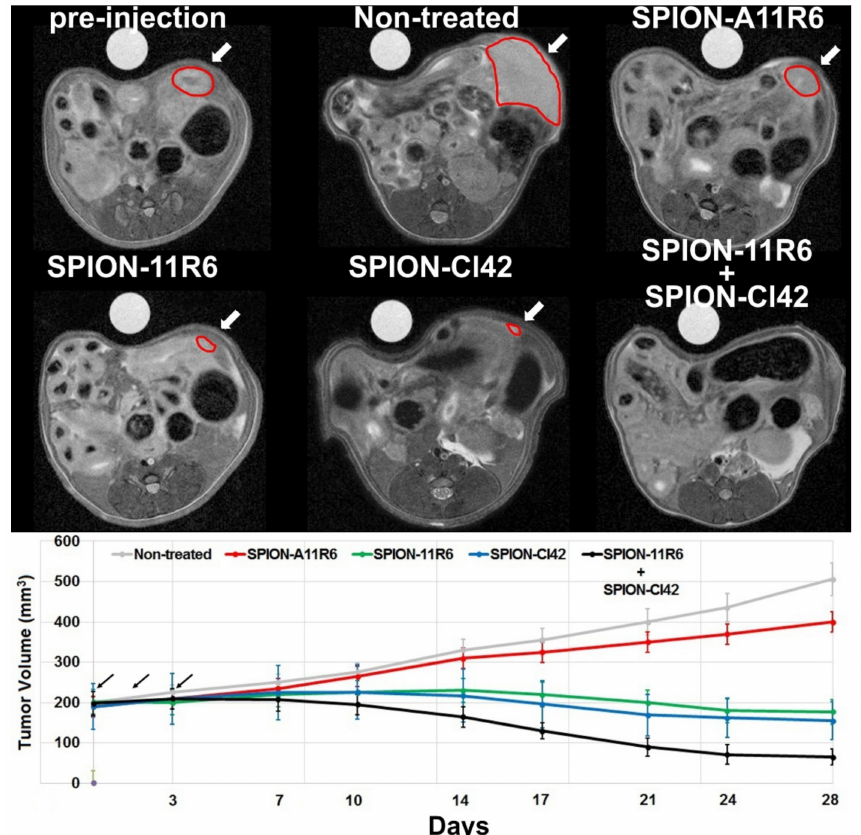
Figure5. In vivoaptamer-conjugatedSPIOnanoparticletherapeutice ffi cacyassessedusingnoninvasive MRI. Representative axial MR images (upper row) and corresponding quantitative measurements of tumor volume (lower row) in 4T1 tumor-bearing mice. Noninvasive imaging protocols were performed pre- ( t = 0; corresponding to three-weeks post-tumor cell inoculation in the mammary fat pad) and up to 28 days post-injection of three consecutive doses (24 h interval time) of di ff erent aptamer therapeutic formulations. Black arrows highlight the injection time points. Pre-injection, non-treated mice, SPION-A11R6, SPION-11R6, SPION-Cl42RNA, and combined SPION-11R6 + SPION-Cl42RNA mice injected groups. White arrows reveal the tumor location and size highlighted with red contours. Data are expressed as mean ± SD, n = 3 per